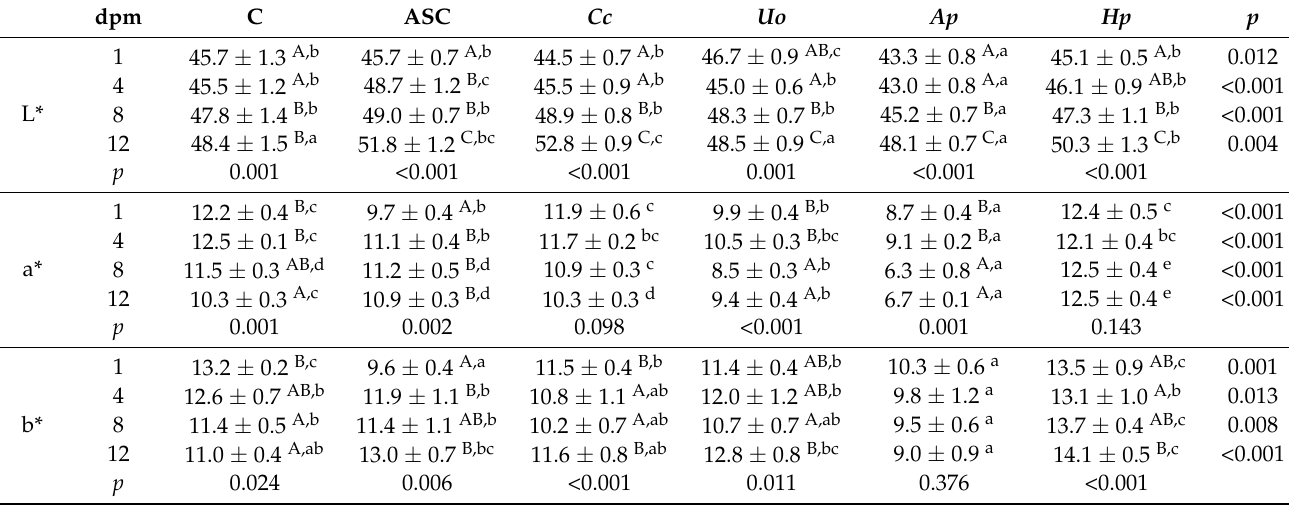
Table 4. Changes in color parameters of rainbow trout fillets treated with algae aqueous extracts throughout a 12-day cold storage (4 ◦ C)